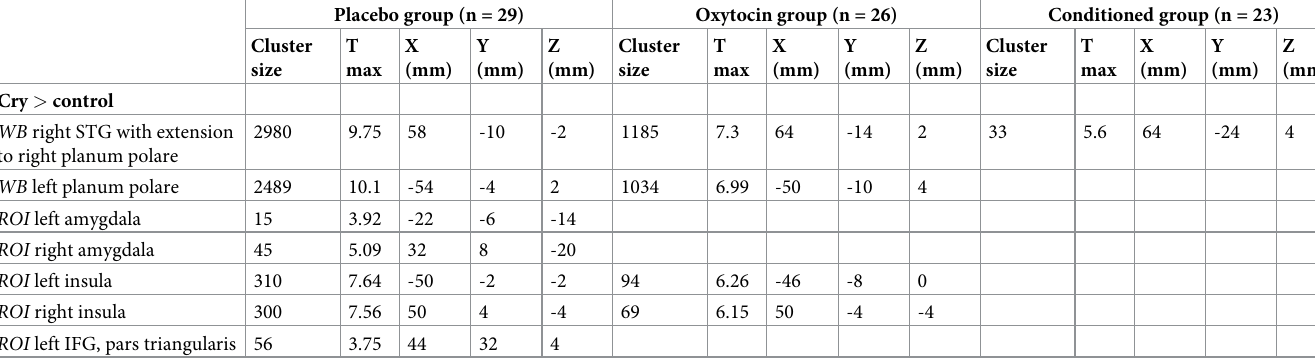
Table 3. Effects of the sound valence across the groups (second level analysis).